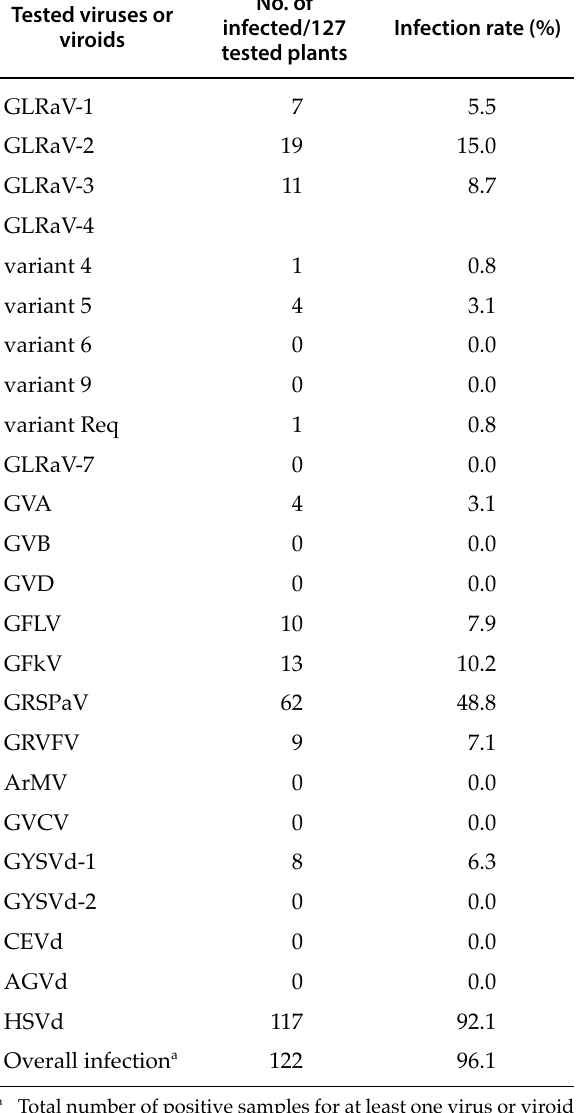
Table 4. Results of virus and viroid testing by RT-PCR. Tested viruses or viroids